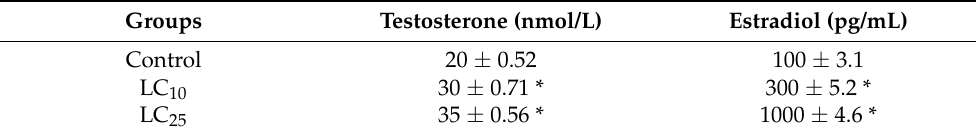
Table 3. SeNP exposure effects on (T) and (E2) concentration of B. alexandrina snails.